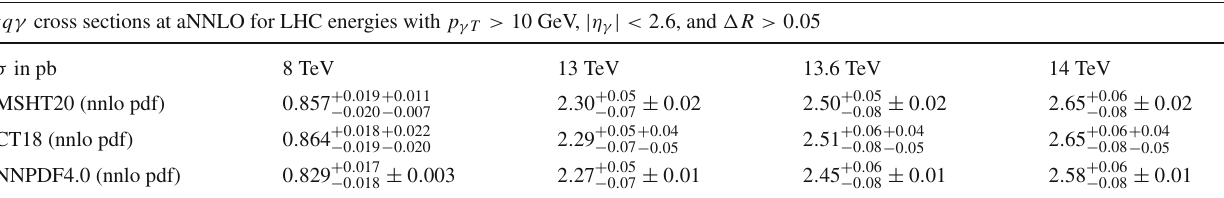
Table 8 The tq γ cross sections at aNNLO (in pb, with central value for μ = m t with scale and pdf uncertainties, and using cuts p γ T > 10, 15, 20, and 25 GeV, as well as | η γ | < 2 . 6 and (cid:7) R > 0 . 05) in pp collisions with tq γ cross sections at aNNLO for 13.6 TeV LHC energy with | η γ | < 2 . 6 and (cid:7) R > 0 . 05